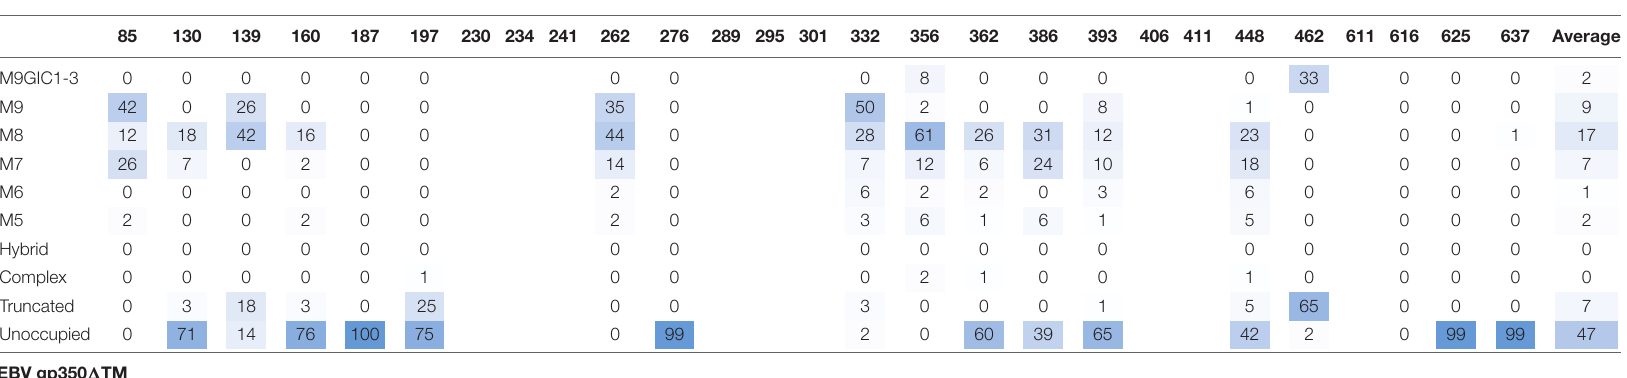
TABLE 1 | Site-specific glycosylation of plant produced CAP256 SU gp140 SOSIP.664 and EBV gp350 (cid:49) TM. CAP256 SU